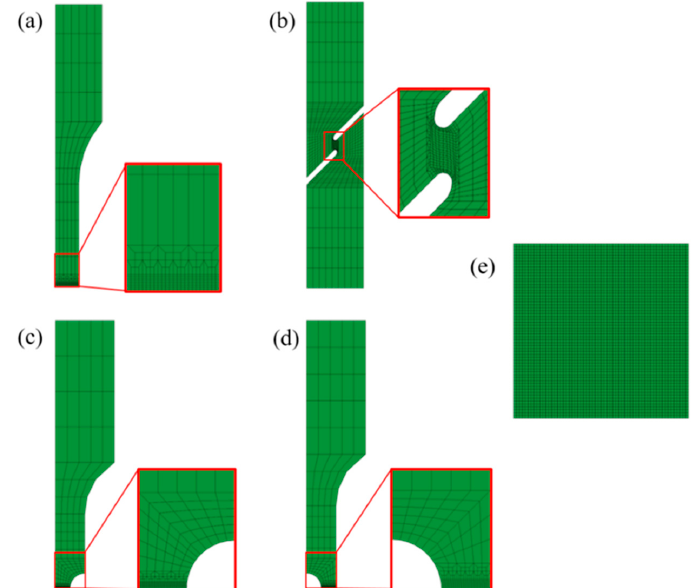
Figure 8. Meshes at ambient temperature for specimens under various stress mode: ( a ) Dog-bone specimen; ( b ) shear specimen; ( c ) notched specimen; ( d ) central hole specimen; ( e ) Nakajima speci- men.